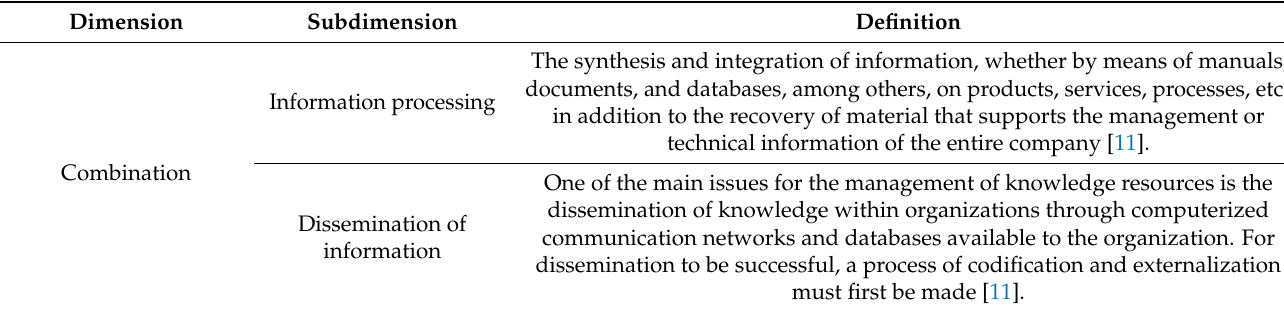
Table 3. The combination